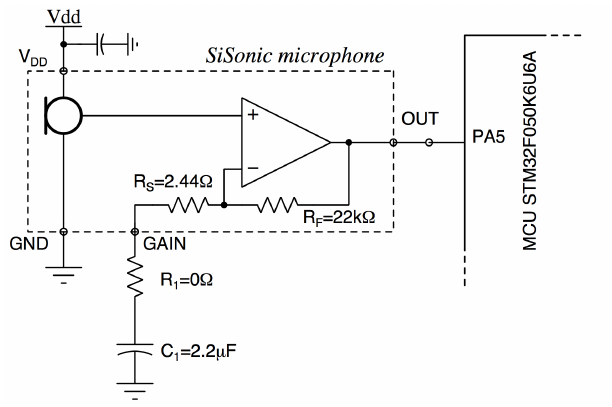
Figure 8. The interface circuit of the Sisonic microphone. The output is connected to the integrated 12-bit ADC (pin 5) of STM32F050K6U6A